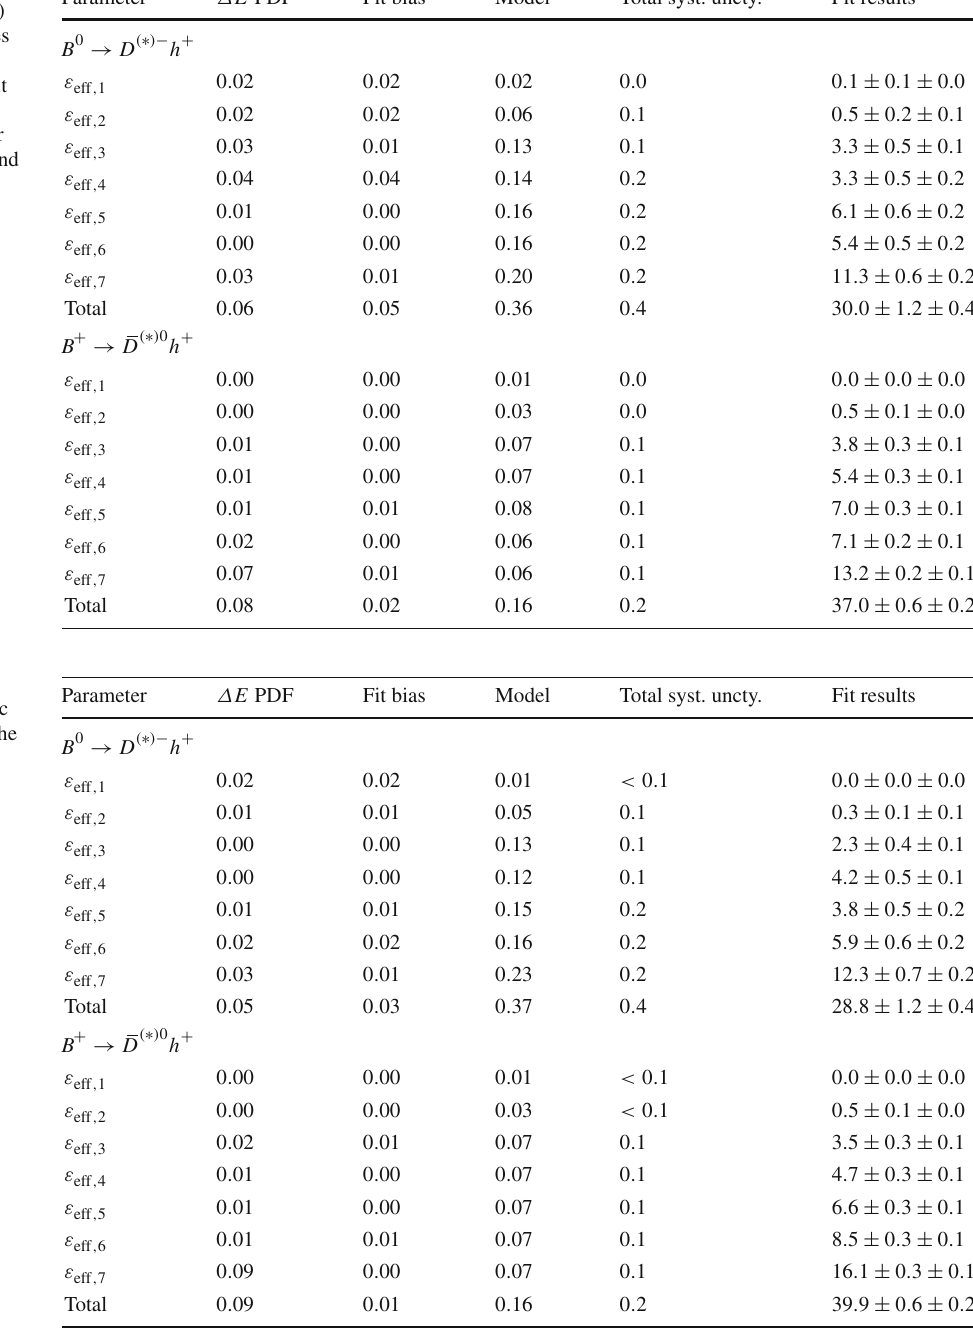
Table 7 Effective efficiencies for the category-based (FBDT) tagger: systematic uncertainties associated with the Δ E parametrization, fit bias, and fit model, and total systematic uncertainty are shown together with the fit results (with stat. and syst. uncertainty). The results are given in percent